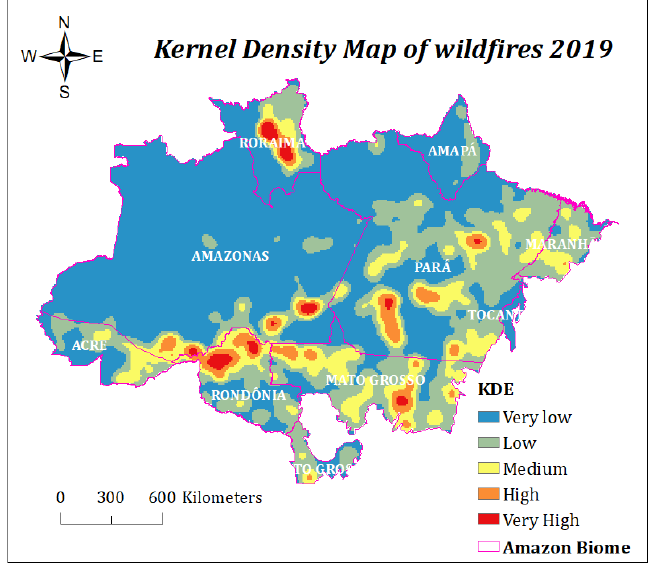
Figure 4. Kernel density map of wildfire incidents in Amazônia Biome in 2019.